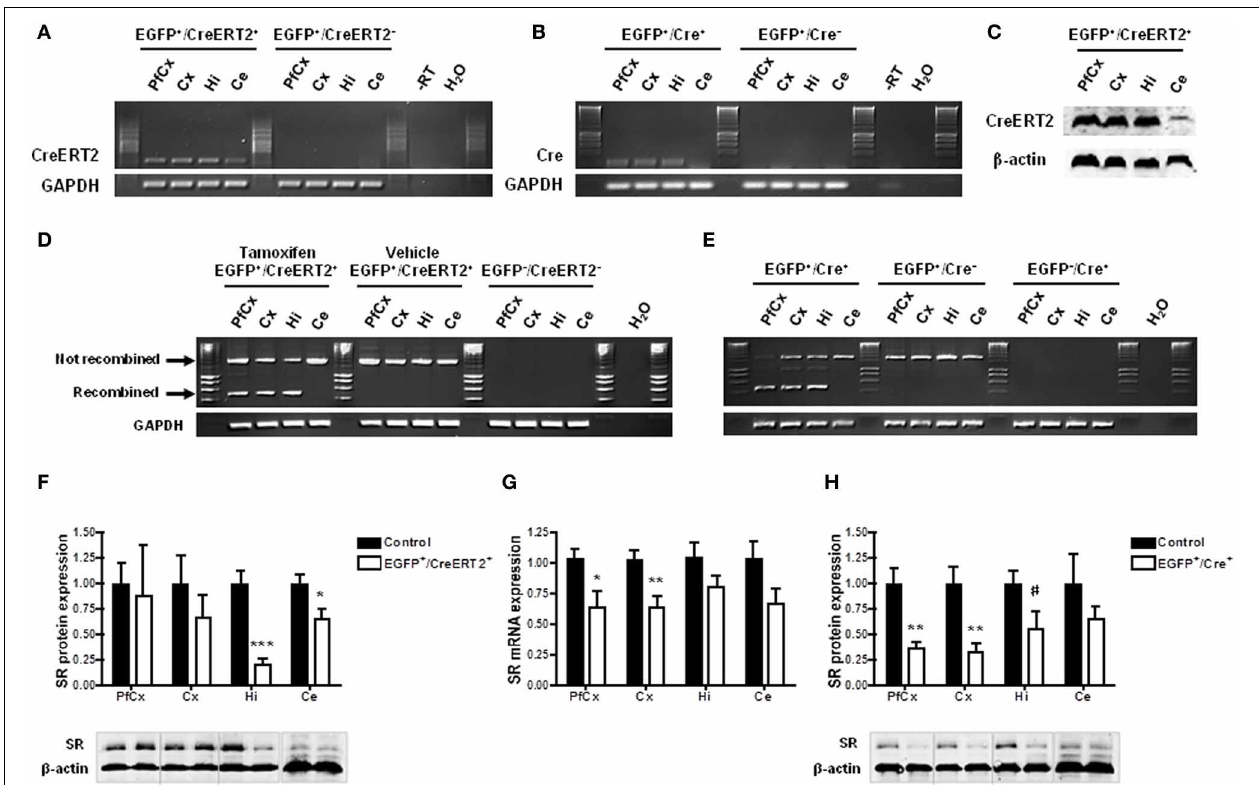
FIGURE 6 | Constitutive and inducible neuron-specific gene knockdown in the adult mouse brain. (A,B) RT-PCR showing Cre expression in pSico-shRNA3 × CaMKII α -CreERT2 (EGFP + /CreERT2 + ) (A) and pSico-shRNA3 × CaMKII α -Cre (EGFP + /Cre + ) forebrain structures (B)